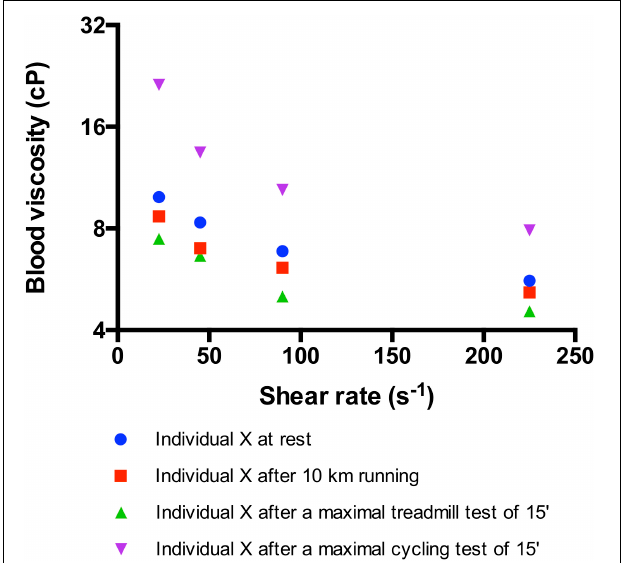
FIGURE 1 | Effects of different kind of exercise on blood viscosity measured at several shear rates in the same trained subject (maximal oxygen consumption, VO 2 max = 64 ml/kg/min). The maximal treadmill and cycling tests consisted in a progressive and maximal exercise conducted until VO 2 max and performed in laboratory conditions (temperature: 24 ◦ C). The 10 km running was performed outdoor (20 ◦ C) and at the highest intensity the subject could run. Indeed, the subject ran at 77% of his maximal aerobic velocity determined on the treadmill and reached a heart rate of 92% of his maximal heart rate. The subject did not drink water during each test. For the three tests, blood was sampled immediately at the end of the exercise and blood viscosity was measured with the same cone-plate viscometer within 1 h after